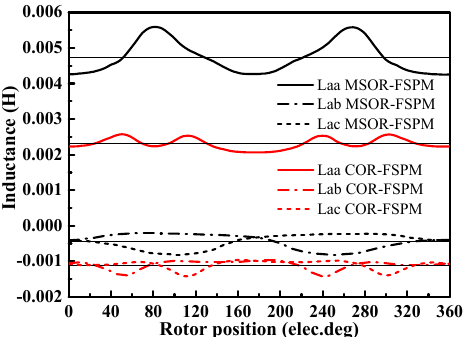
Figure 20. Waveforms of self-inductance and mutual-inductance in the MSOR-FSPM motor and COR-FSPM mot